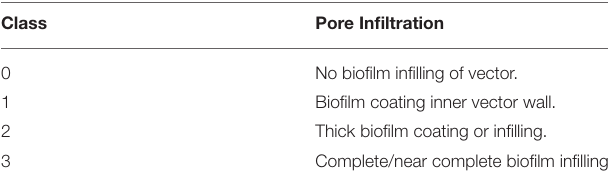
TABLE 2 | Degree of biofilm infiltration into observed natural vectors in bone samples of G. gallus domesticus , defined as 4 distinct nominal Classes (after Peterson et al.,